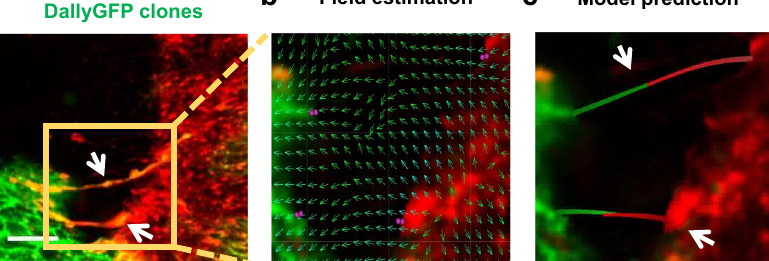
overexpressing Ihog confronted with clones overexpressing Dally. White arrows show the cytonemes to be simulated. b ’ Guidance fi eld estimation (green small arrows) of the experimentalconditions eliminating selected cytonemes. c ’ In silico predicted trajectories for the simulated cytonemes. Scale bars: 15 μ